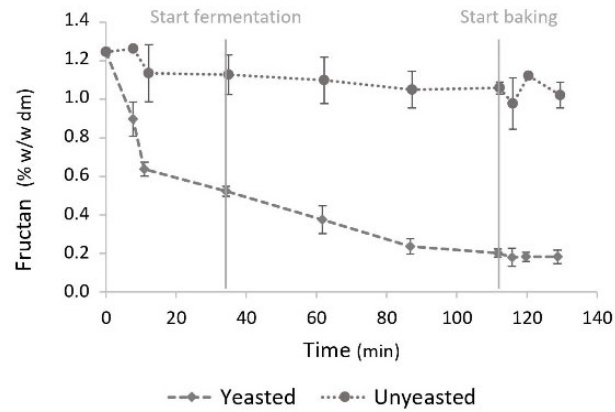
Figure 3. Evolution of fructan concentrations in pastry samples with or without yeast as a function of time (min) during pastry production. Concentrations are expressed on flour dry matter base (% w / w dm flour). The start of mixing is defined as t = 0. The end of the mixing phase, and the start of the fermentation and baking phases are displayed. Vertical bars represent standard deviations of duplicate measurements.